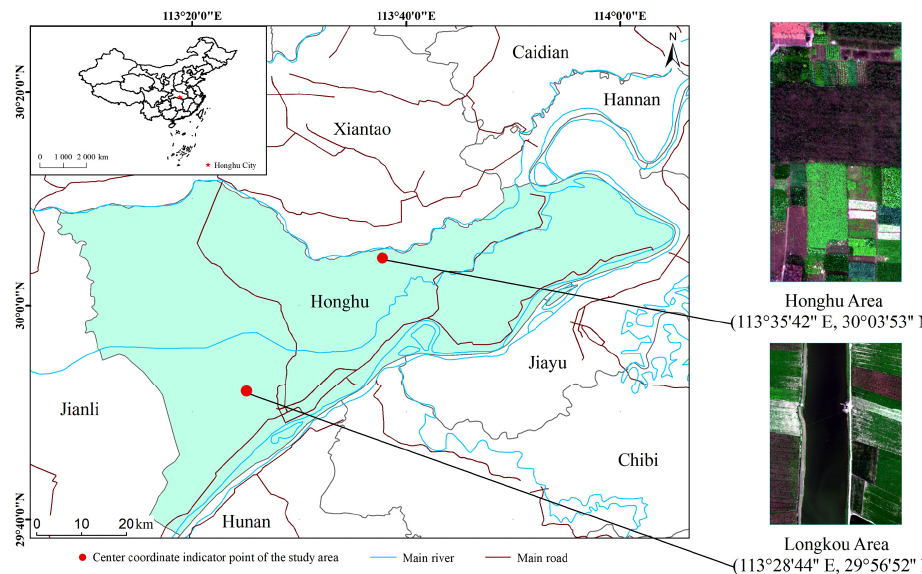
Figure 1. Location of the study area.